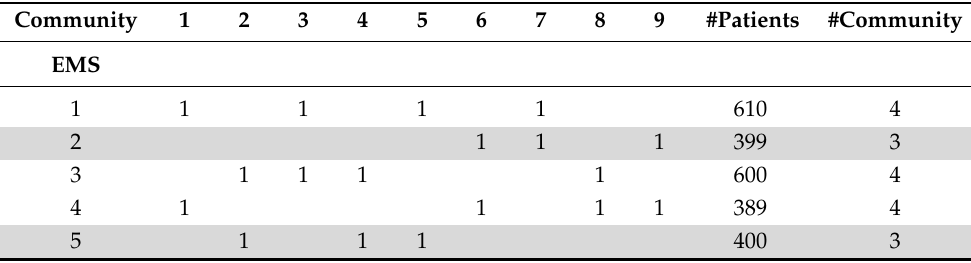
Table 3. Community assignment results.